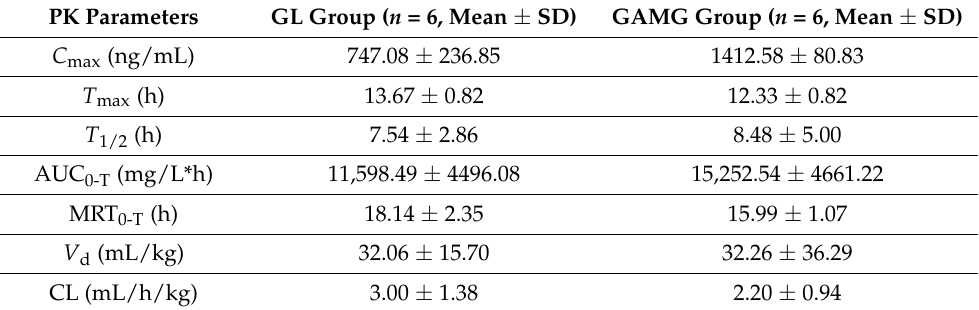
Table 9. Pharmacokinetic parameters of GA after intragastric administration of GL and GAMG ( n =